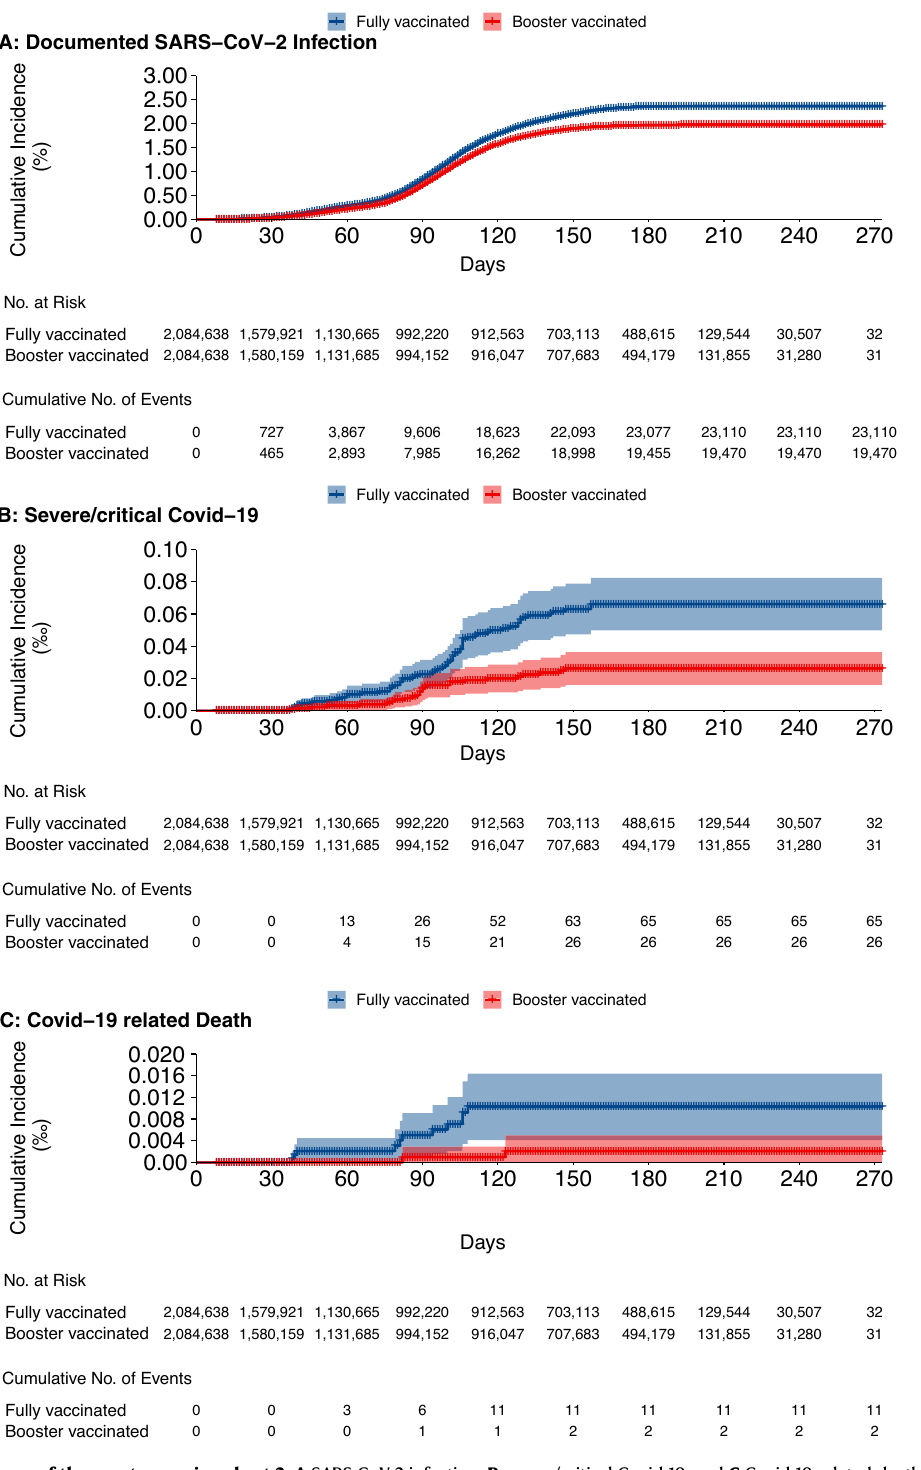
Fig. 4 | Cumulative incidence of three outcomes in cohort 2. A SARS-CoV-2 infection, B severe/critical Covid-19, and C Covid-19 related